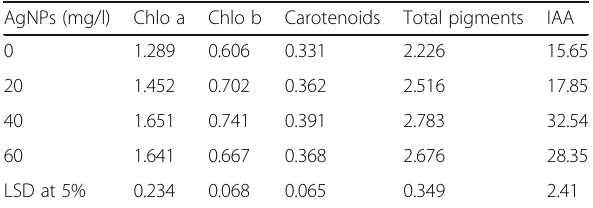
Table 2 Effect of different concentrations of AgNPs on photosynthetic pigments of (mg/100 g fresh wt.) fenugreek plants (at 60 DAS)